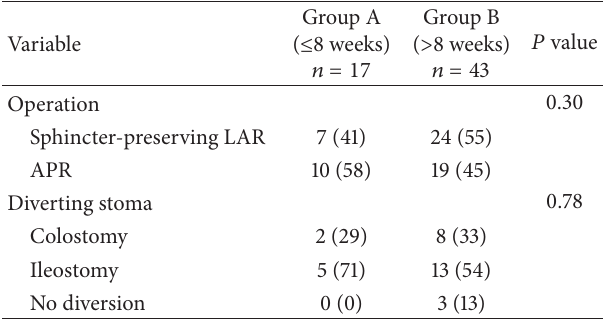
Table 5: Pathological